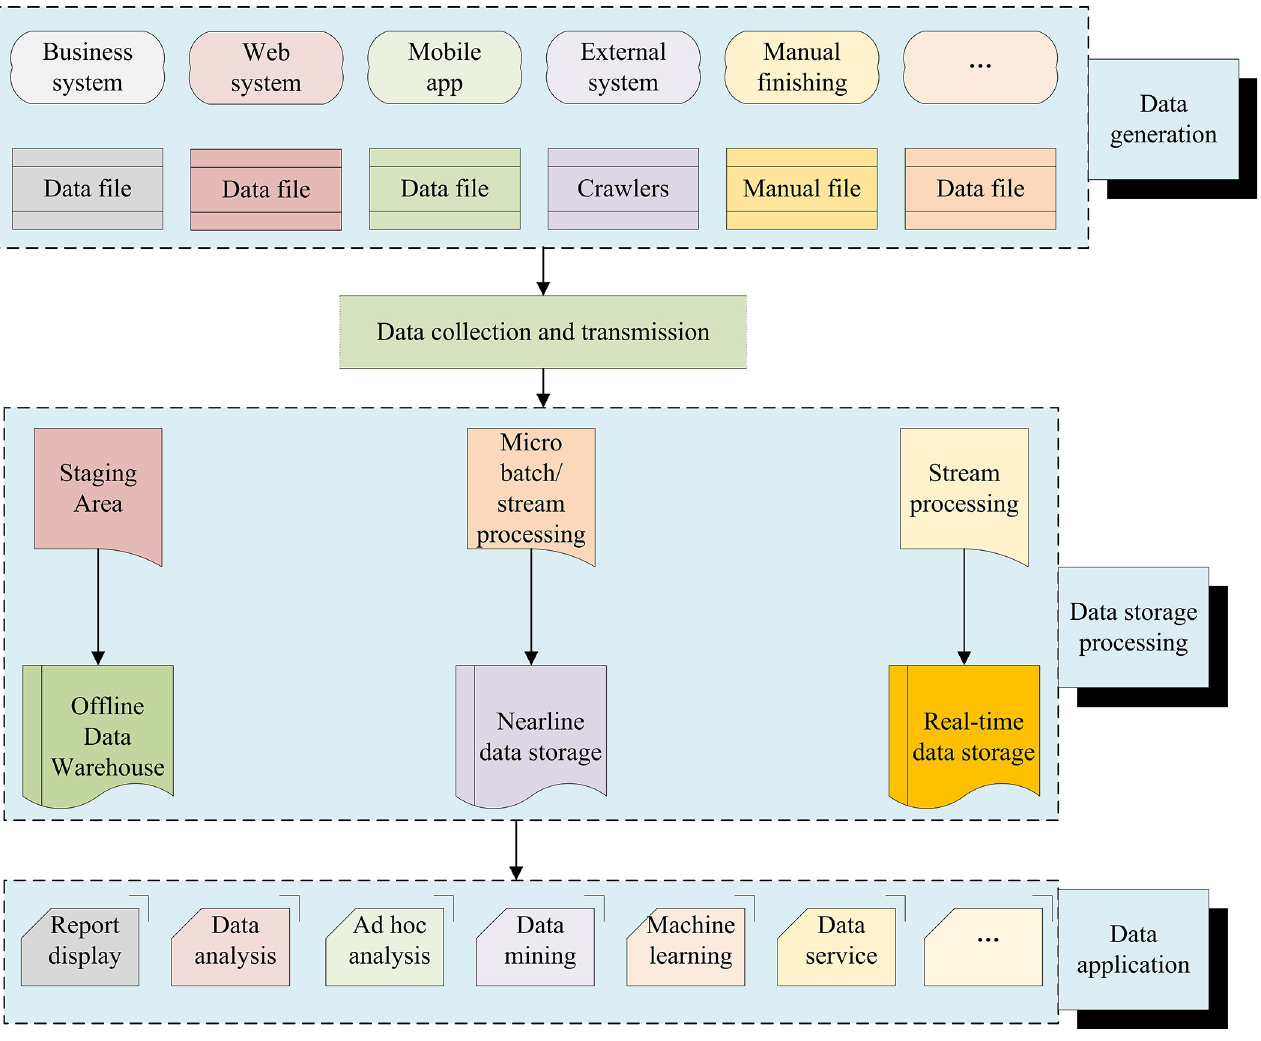
Fig 1. Principle of